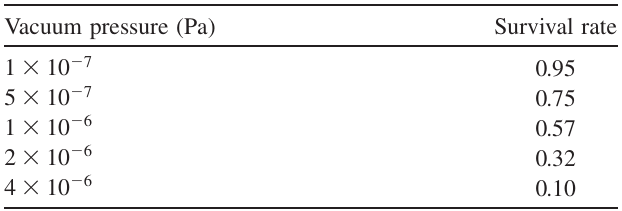
TABLE V. Survival rate of the argon beam.